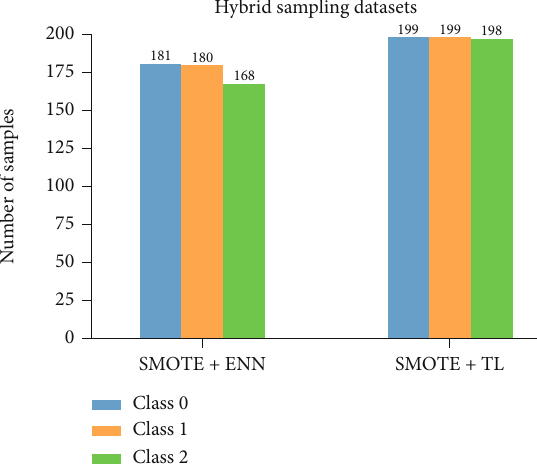
Figure 8: Number of samples per class in the datasets which hybrid sampling SMOTE+ENN and SMOTE+TL are applied.